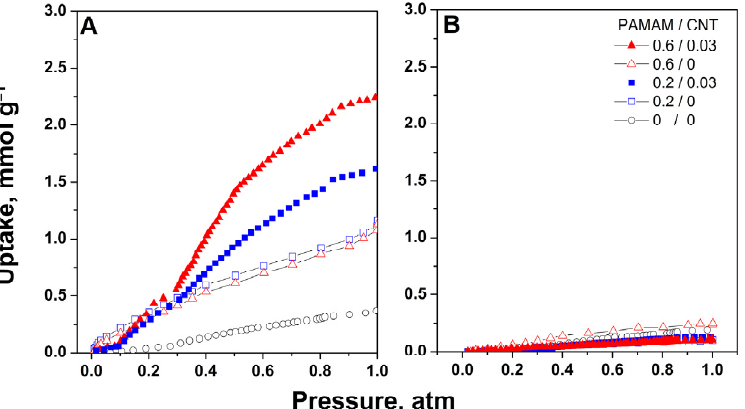
Figure 8. CO 2 ( A ) and N 2 ( B ) adsorption isotherms on GO aerogels before and after modification with PAMAM dendrimer and CNT (mg mL − 1 ) addition at 25 °C.